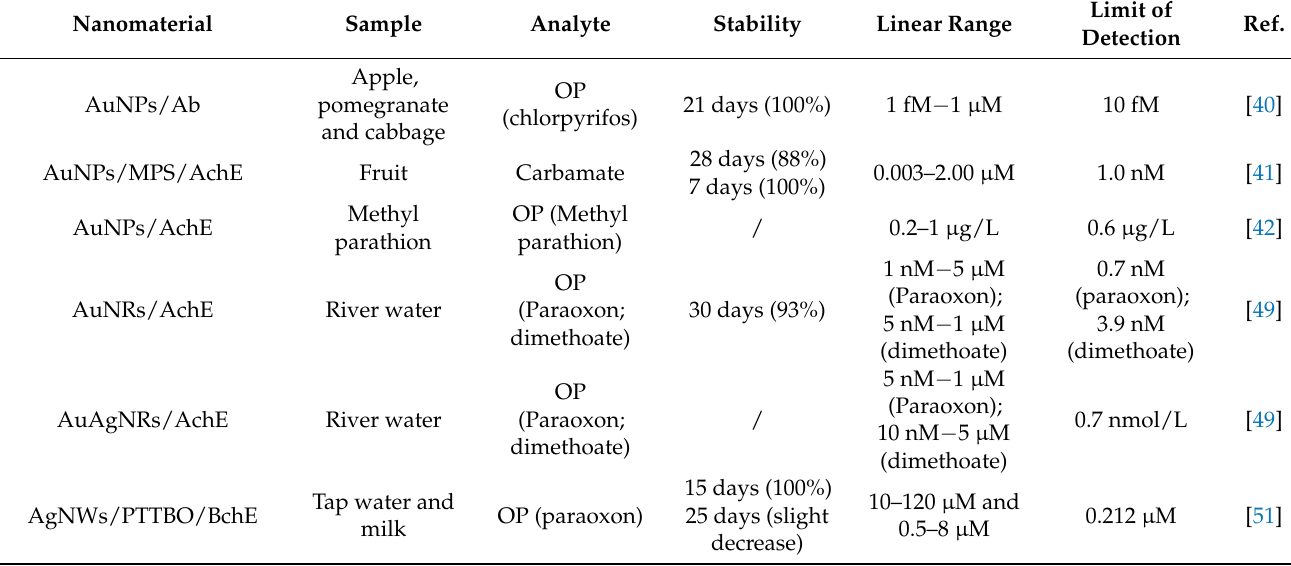
Table 3. Representative studies of electrochemical biosensors for detecting pesticides from food samples by metal nanomaterials.